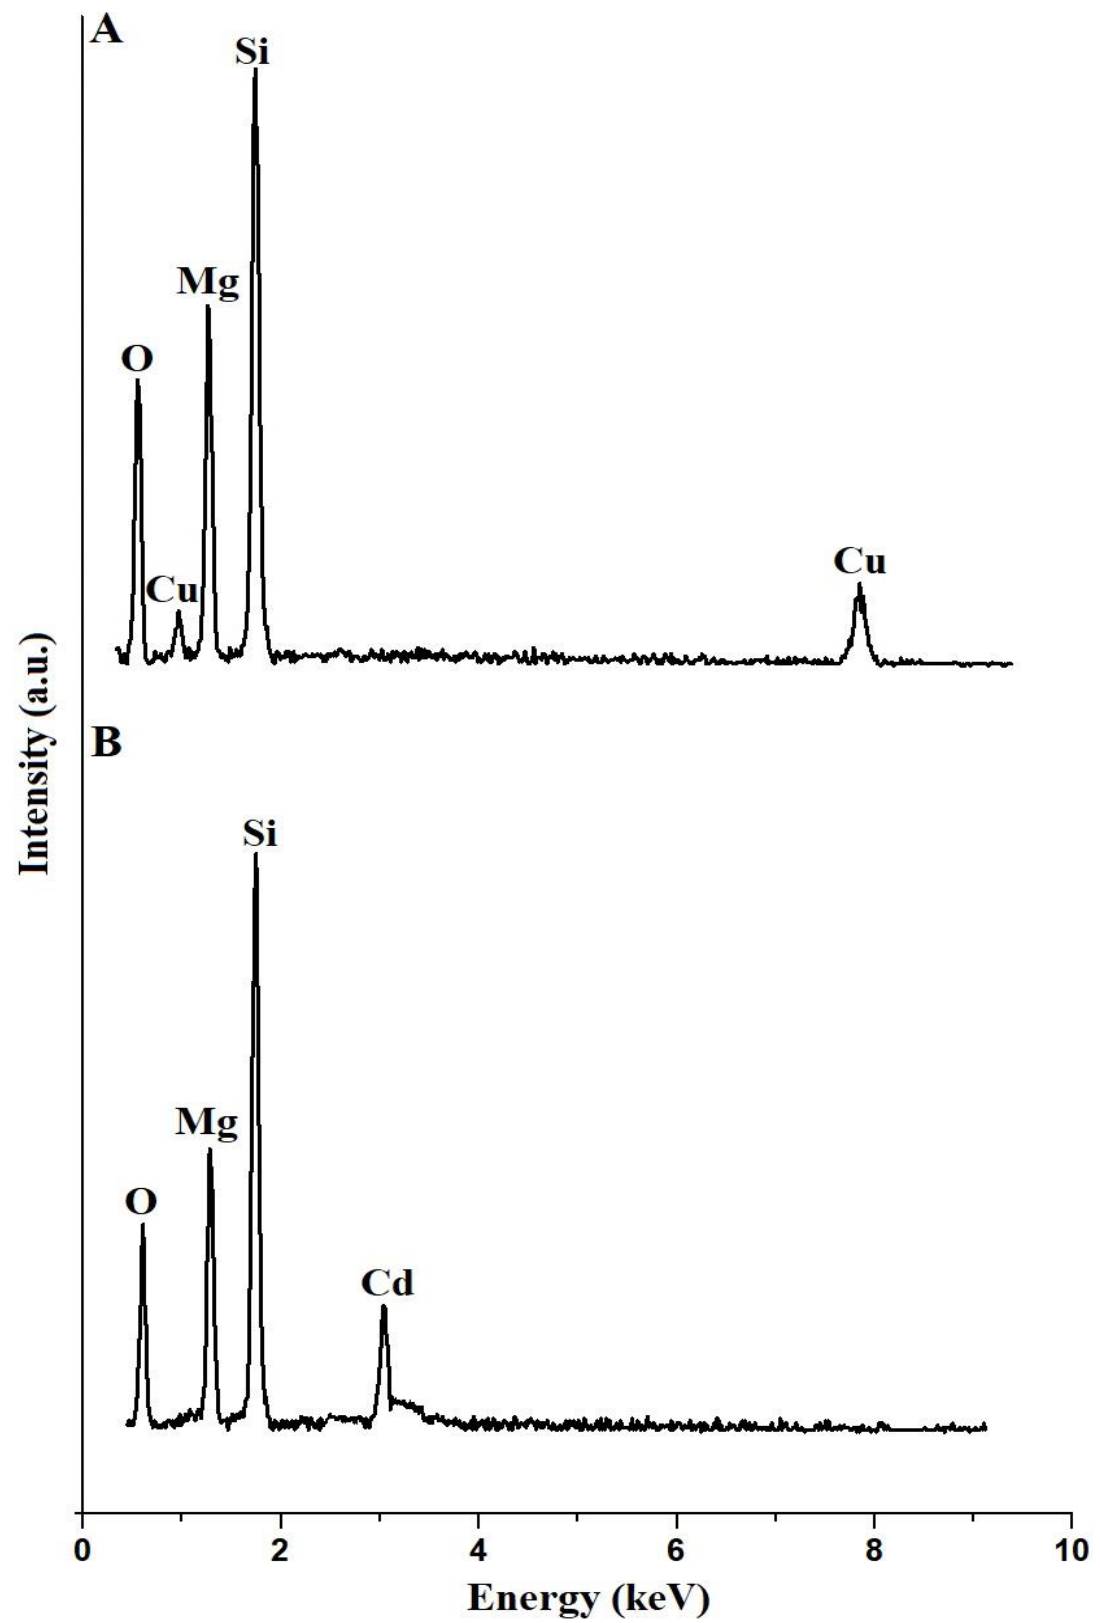
Figure 15. The EDX patterns of the Cu(II)–F1 ( A ) and Cd(II)–F1 ( B ).